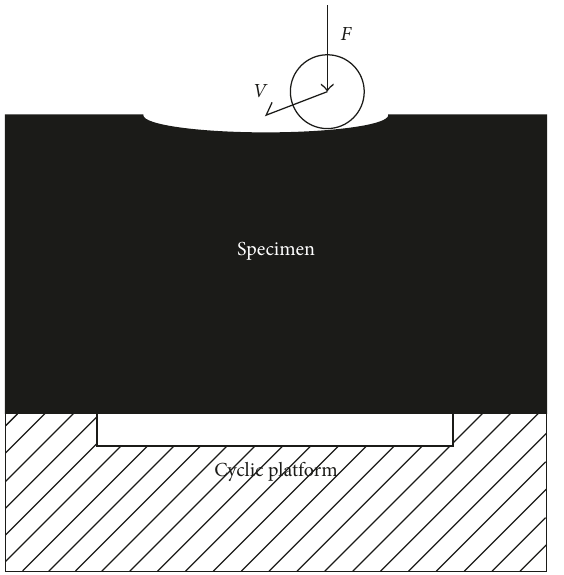
Figure 10: Stress pattern of specimen. Table 2: Gradation of AC-20 asphalt mixtures.